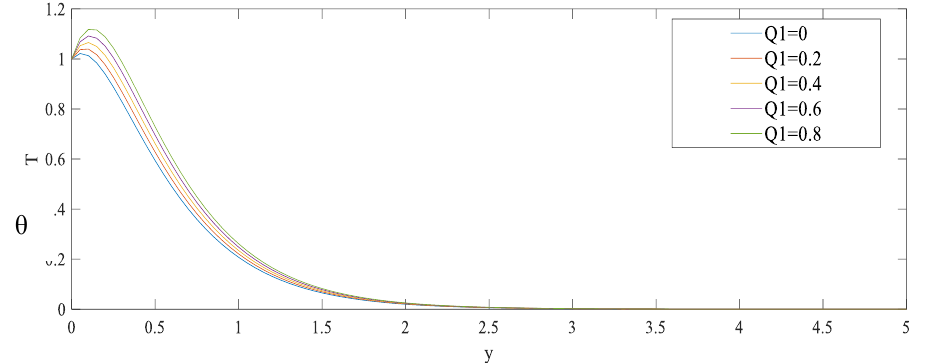
Figure 8: Temperature profile against displacement variable y for Nr=0.1, Pr=5, M=2, b=0.5, Sc=2, Kr=0.5, Du=0.5, Q=0.2, e=0.001, eta(η) =0.2, n=0.1, Kp=0.3, Gr=5, n 1 =0.2, h=0.4, Gm=0.3 at